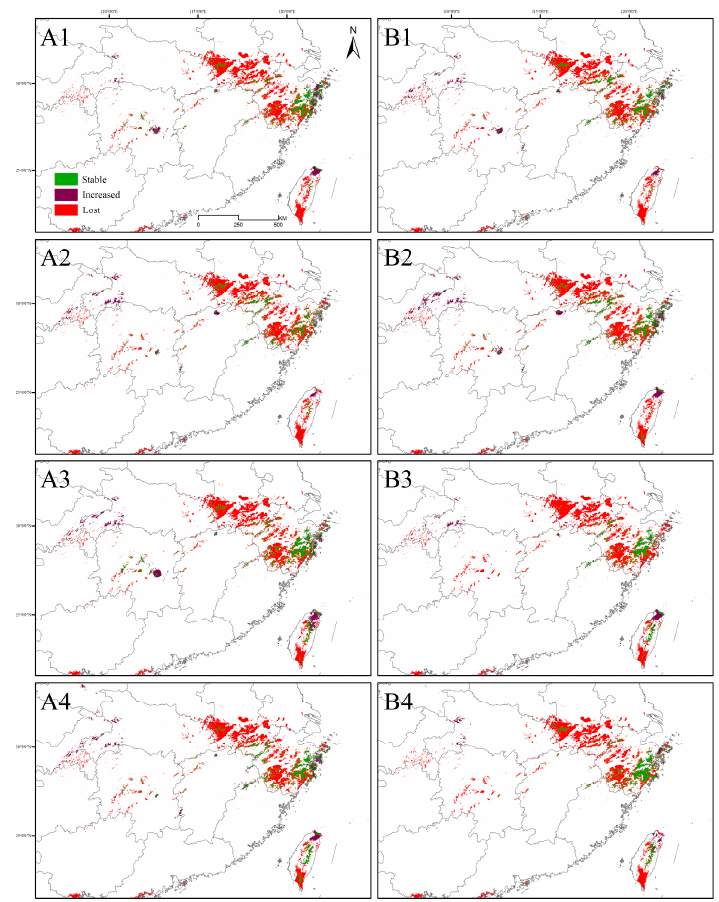
Figure 6. Dynamic changes of the suitable distribution area of Carpinus tientaiensis under current and future climate scenarios. ( A1 – A4 ), 2050s; ( B1 – B4 ), 2070s; 1, future climate scenario RCP 2.6; 2, future climate scenario RCP 4.5; 3, future climate scenario RCP 6.0; 4, future climate scenario RCP 8.5;